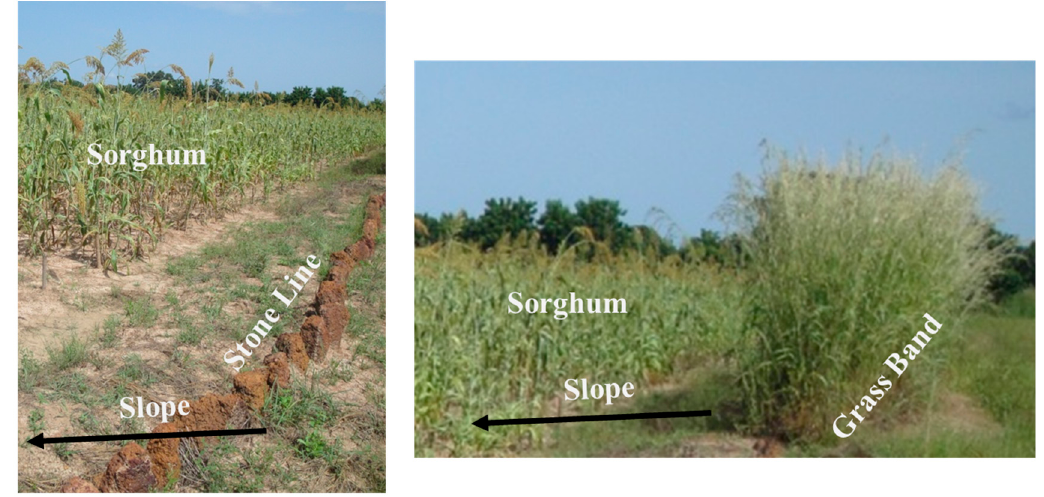
Figure 3. Layout of the stone line and grass band water conservation methods (WCM) at Saria Research Station, Burkina Faso.